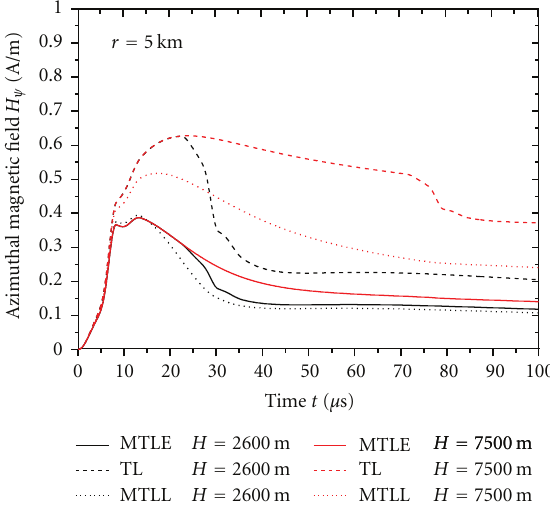
Figure 12: Azimuthal magnetic field at 100 km from the channel base for NCBC, three di ff erent models and two channel heights ( H = 2600m and 7500 m).